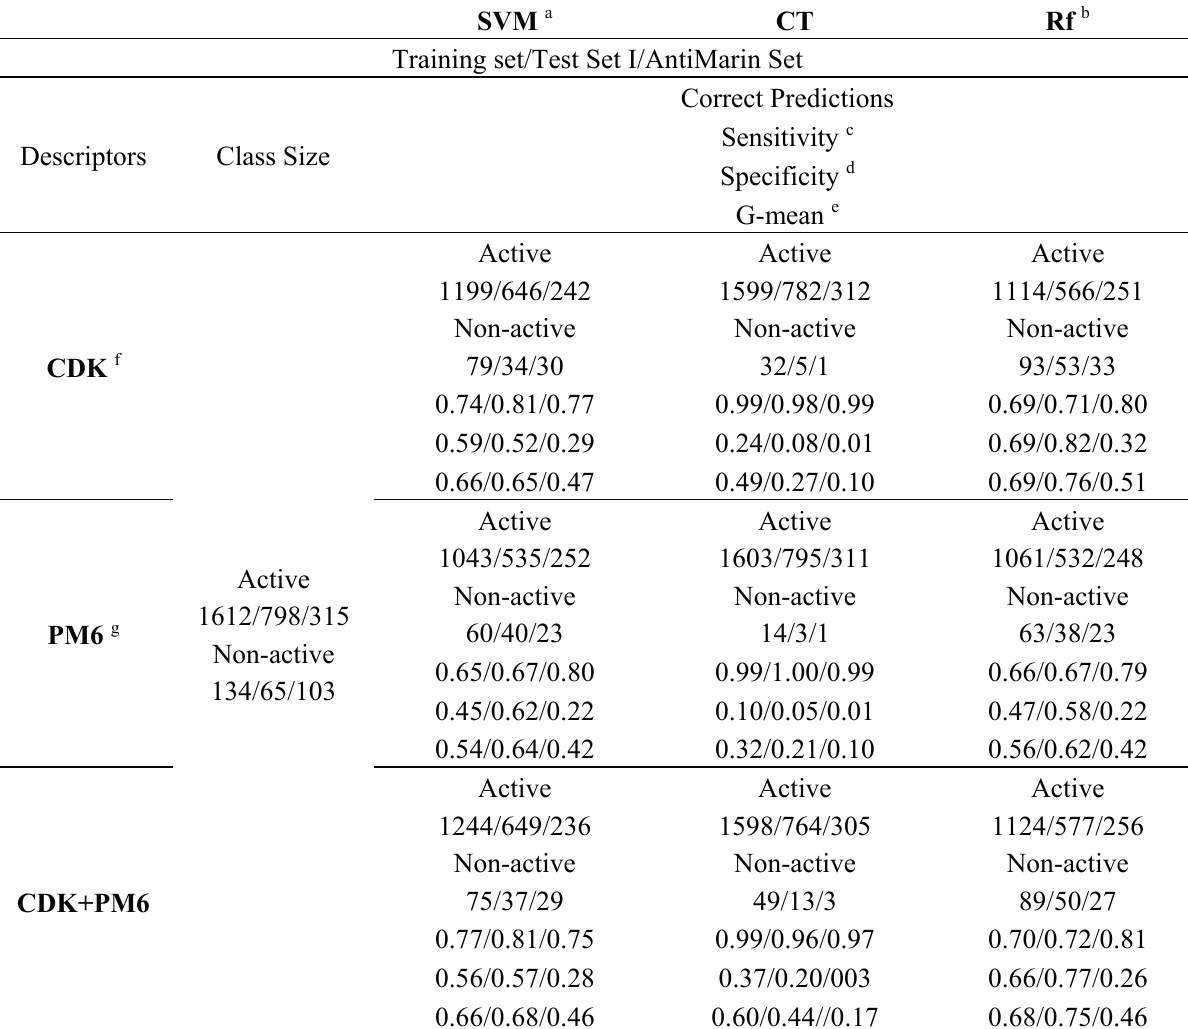
Table 1. Comparison of different ML techniques and descriptors for building overall biological activity classification